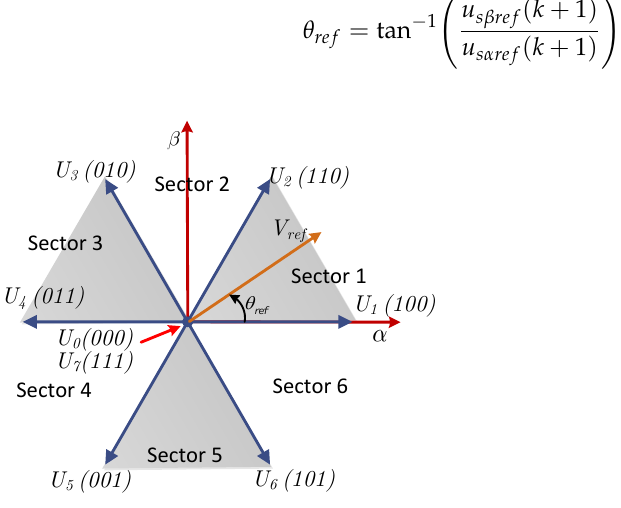
Figure 1. Representation of the voltage vector of the power inverter in the α − β